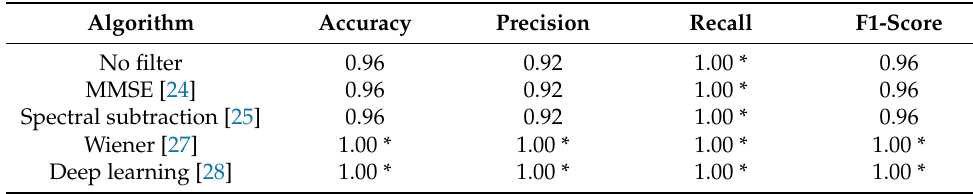
Table 7. White Noise SNR − 5. * is the best result for each particular measure.